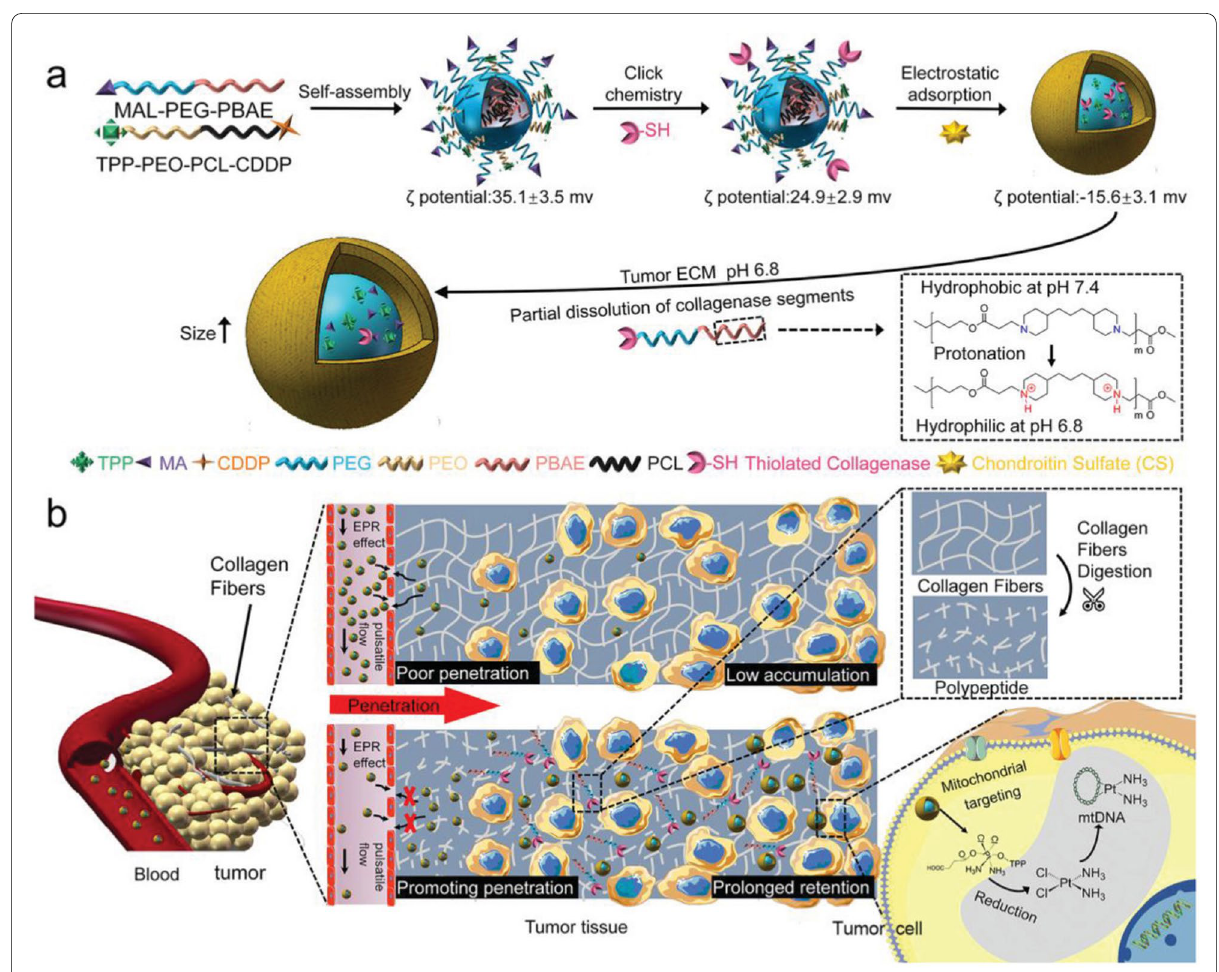
Fig. 3 a Schematic illustration of the fabrication of collagenase-based nanoscavengers and their size increase and dissociation of the collagenase containing components in response to the acidic pH. b Schematic illustration of the increased penetration and retention of nanoparticles in deep tumor tissues via the combined action of collagenase digestion of collagen fibers and particle size increase, and the destruction of mitochondrial DNA via mitochondria-specific targeting and release of cisplatin drugs into mitochondria. Reproduced with permission from [45]. Copyright 2020,